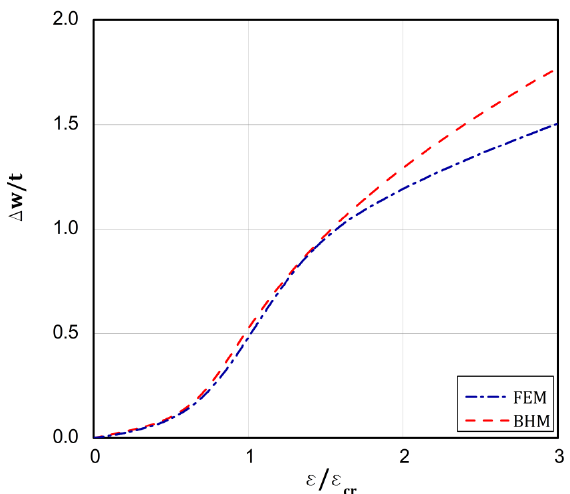
Figure 9. Dependence of tw /  vs. cr /  for variant A and type 4 of loads.